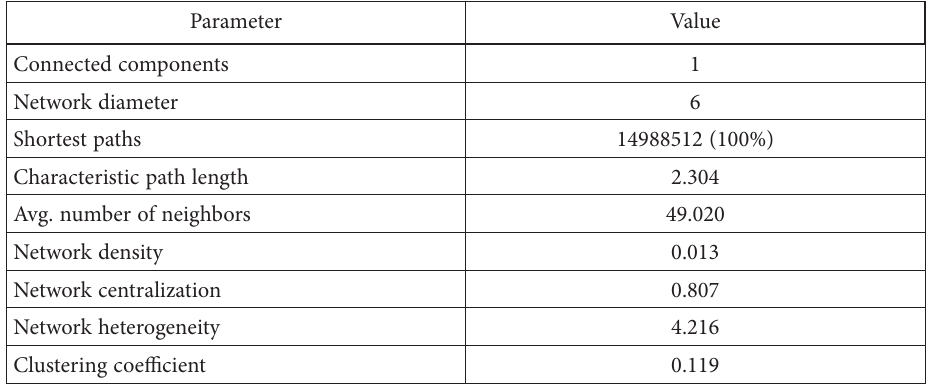
Table 5. The simple parameter value of the network (source: authors’ own